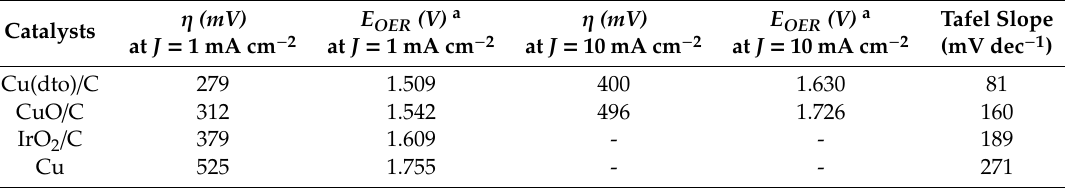
Figure 4. Tafel plots for all tested electrodes. Table 1. Summary of oxygen evolution reaction (OER) performance of the tested materials in N 2 -saturated 1 M